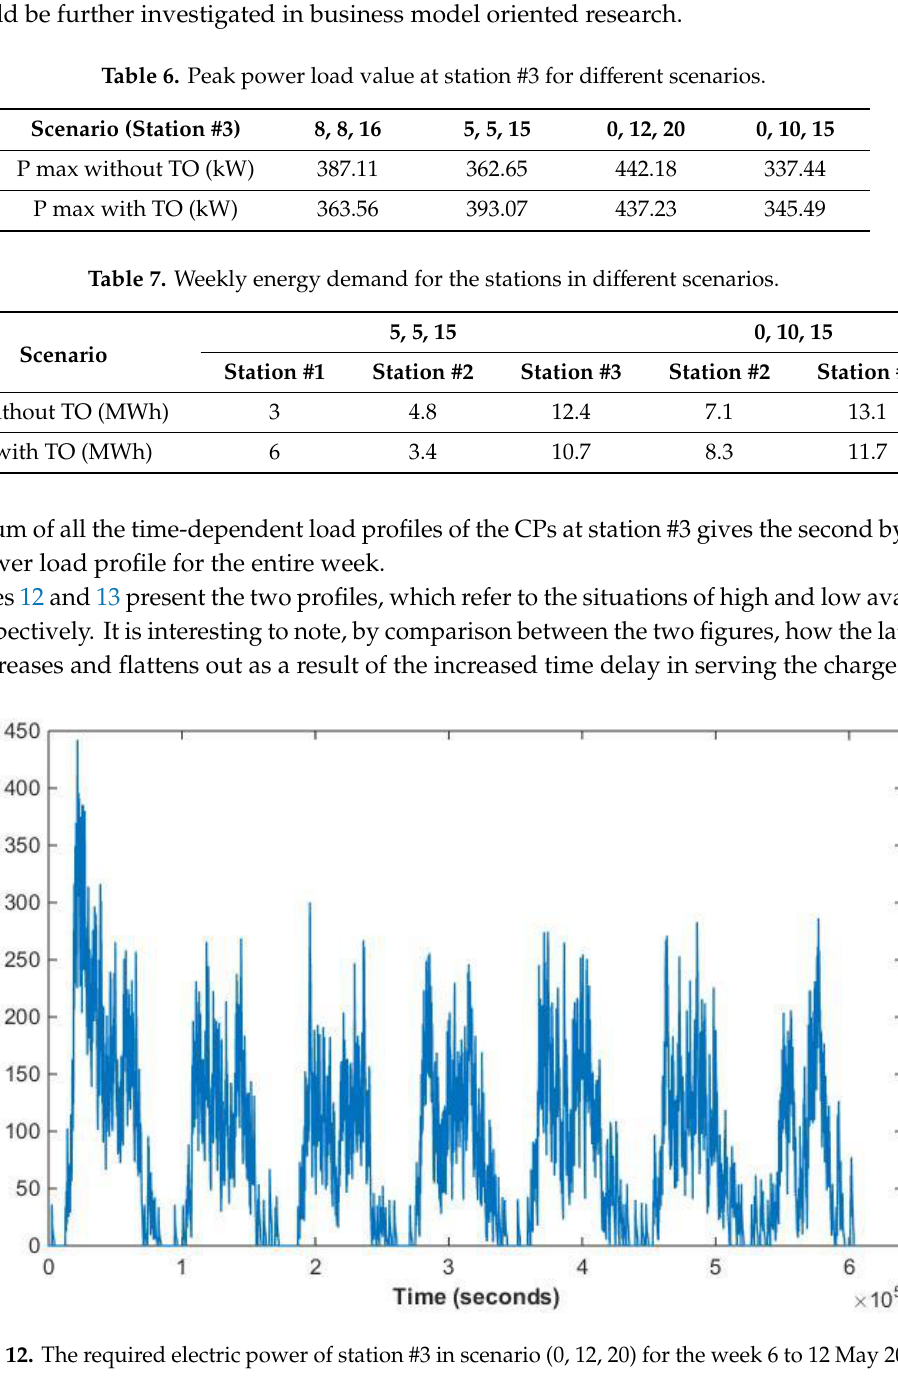
Figure 13. The required electric power of station #3 in scenario (0, 10, 15) for the week 6 to 12 May 2013. In Figures 14 and 15, the number of drivers served by each CP of station #3 is presented by means of two bar diagrams referred to as scenario a) and scenario b), respectively.